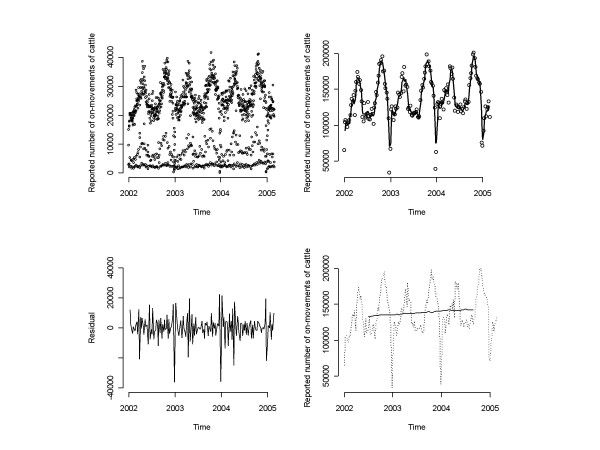
Time series for "on" movements of cattle reported to BCMS over the period 1st Jan 2002 and 28th Feb 2005. (a) Raw data plotted at daily intervals (b) 3-point moving average (raw weekly data shown as unconnected symbols) (c) Residuals after accounting for the 3-point moving average (d) 53-point moving average (raw weekly data shown as unconnected symbols).